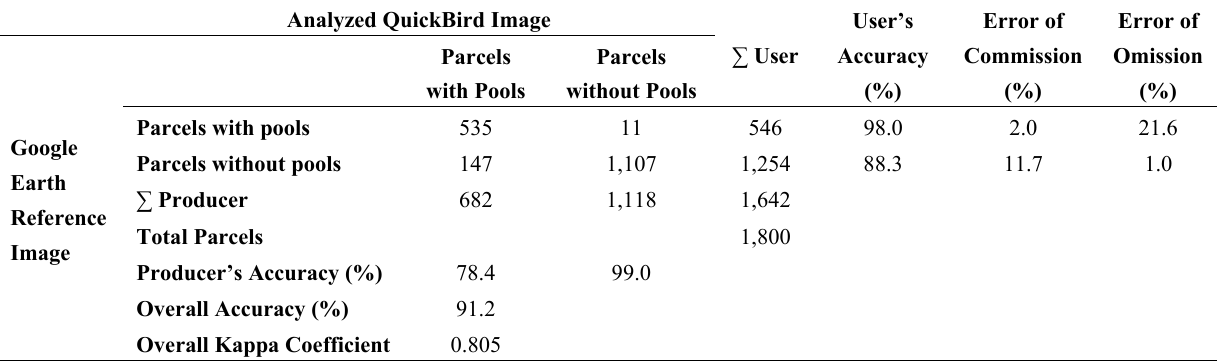
Table 2. Confusion matrix for the method of identifying residential parcels that contain swimming pools for a threshold of NDWI ≥ 0.3. The matrix shows the actual and classified parcels in the columns and rows. The Producer’s Accuracy refers to the accuracy of the analytical refers to the reliability of the analytical